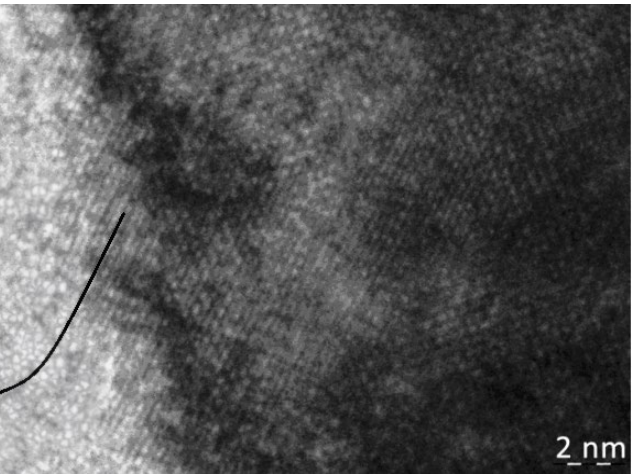
Figure 3. Image from the zone of the flexural extinction contour obtained in a high-resolution transmission electron microscope.